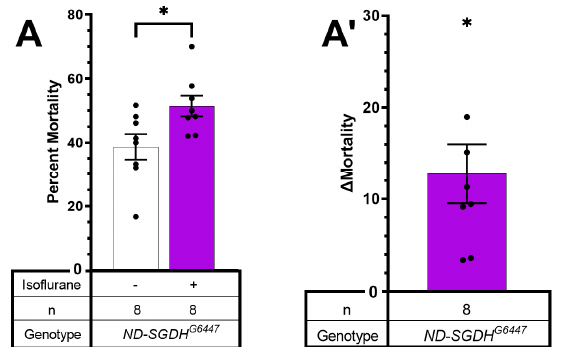
Figure 4. Hyperoxic ISO increases 24 h mortality in ND-SGDH G6447 mutants. ( A ). Flies were exposed to 2% ISO in 75% O 2 for two hours at 15–20 days old, returned to culture vials and scored 24 h after exposure. Mortality increased in mutants but not in wild-type flies ( p = 0.0254, unpaired t -test). ( A’ ). Data as in A, control mortality subtracted ( Δ Mortality). Each dot represents a biological replicate of 15–35 mixed-sex flies. Results presented as mean ± SEM. * p < 0.05.